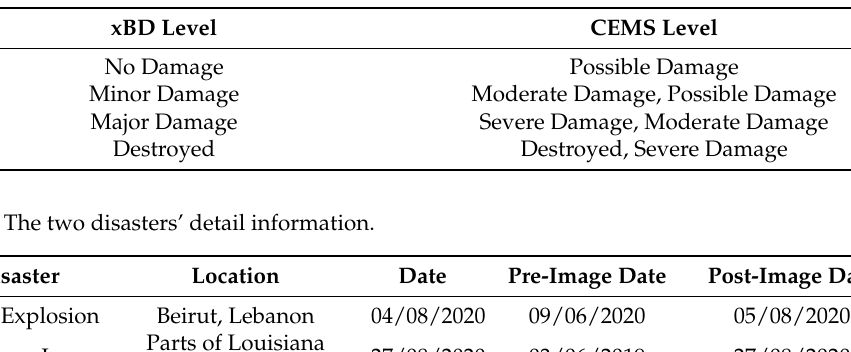
Table 2. Level of correspondence between xBD and Copernicus Emergency Management Service (CEMS).